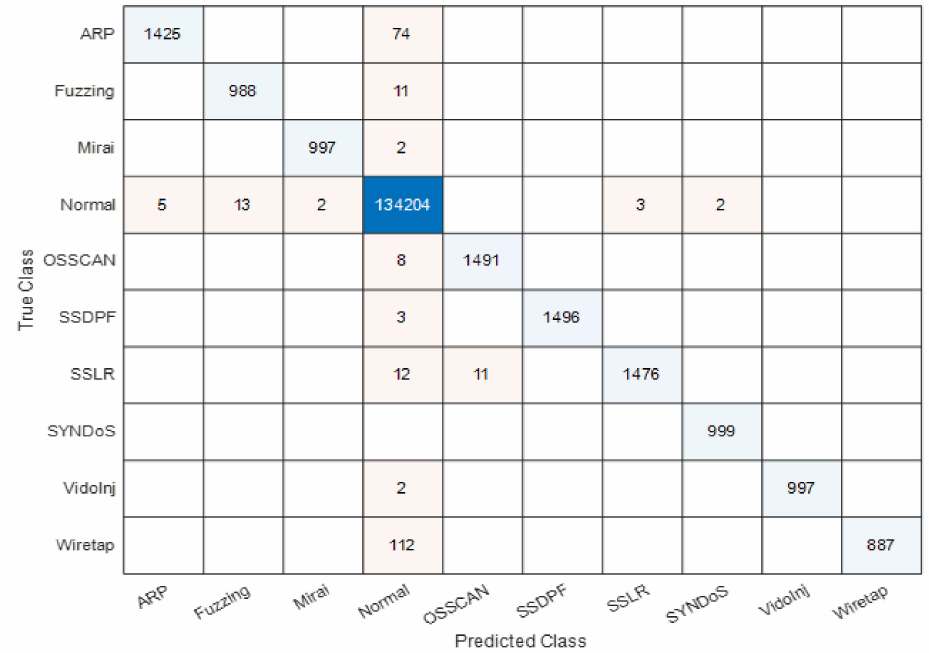
Figure 5. Confusion matrix for Ensemble Boosted Trees (EBT)